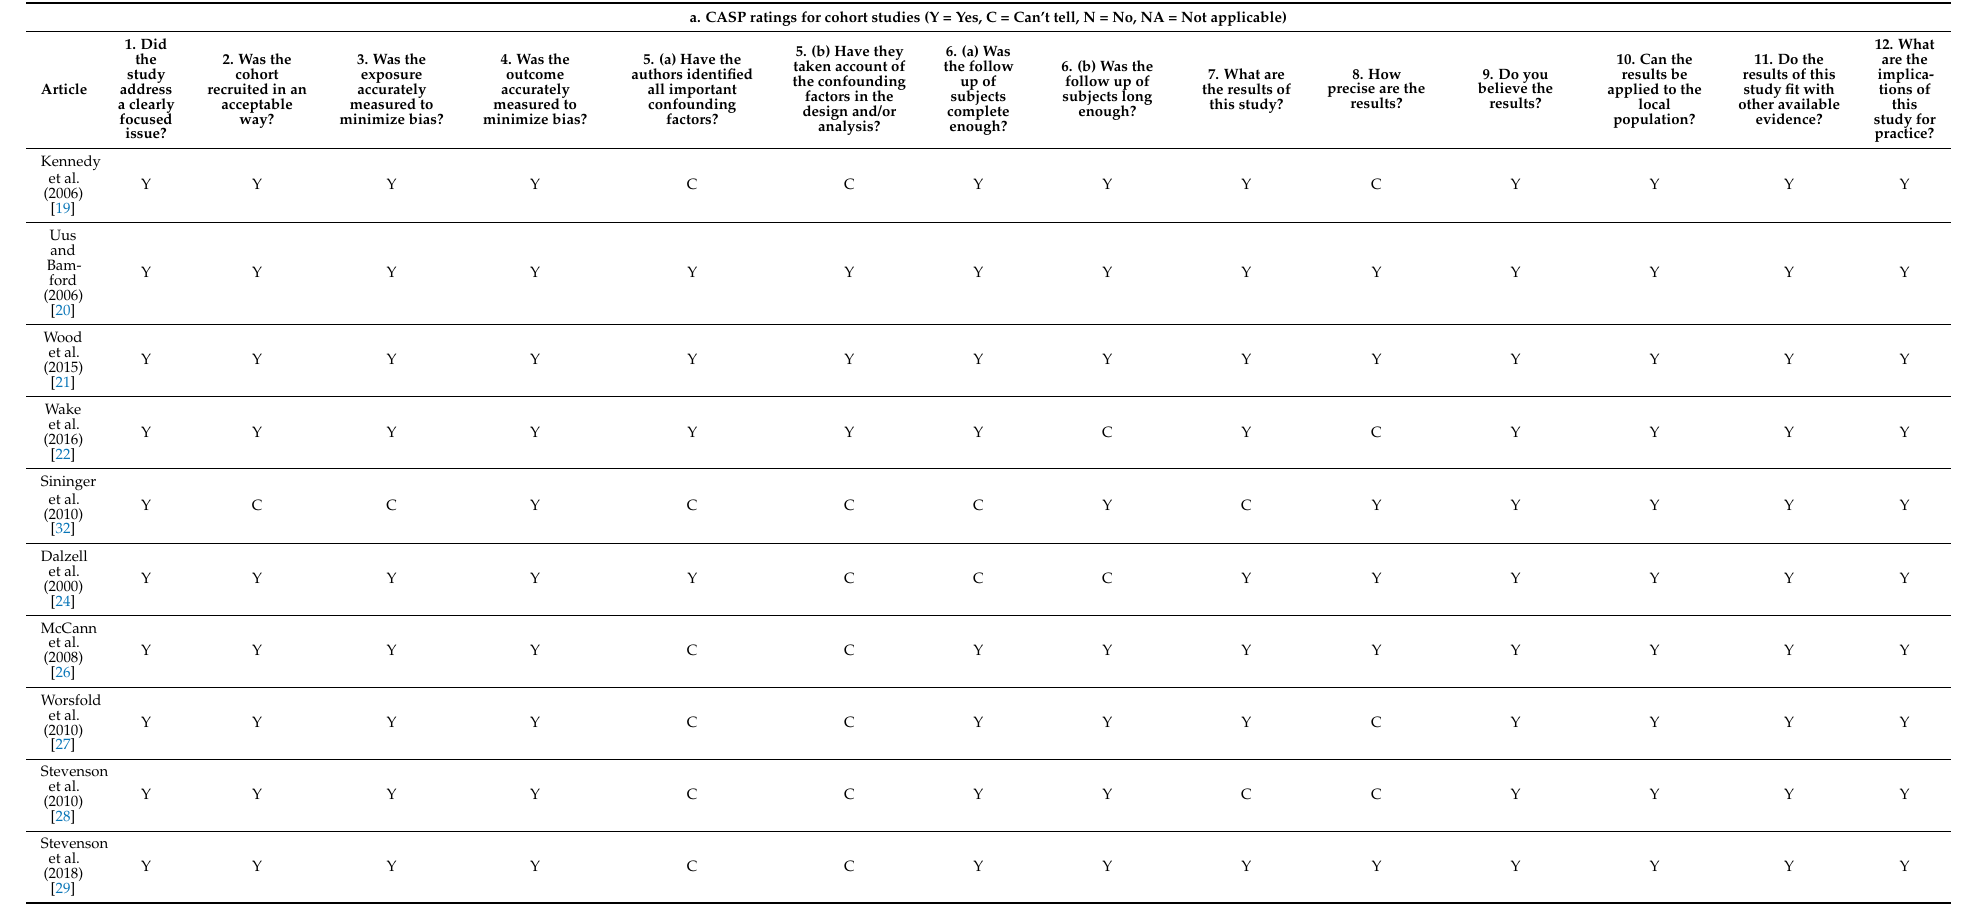
Table 4. CASP ratings for included studies based on its